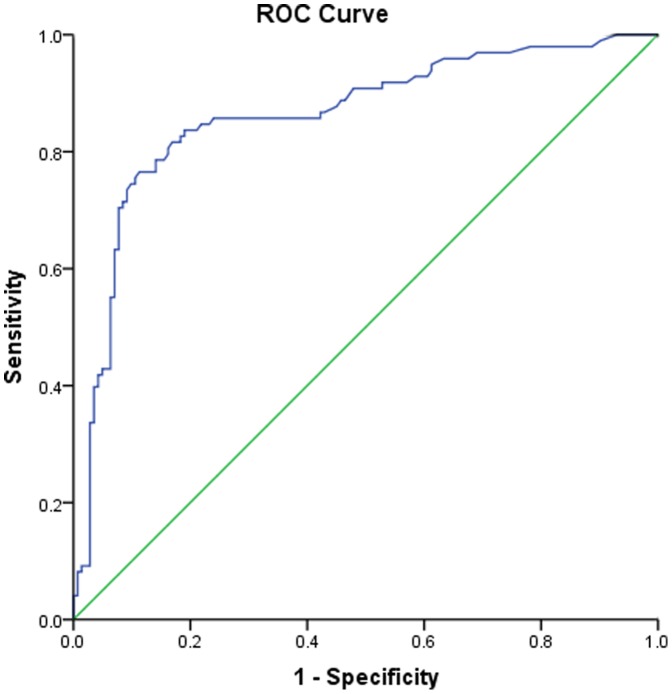
Receiver operating characteristic (ROC) curves were utilized to evaluate the accuracy of D-dimer levels to predict cardioembolic strokes.